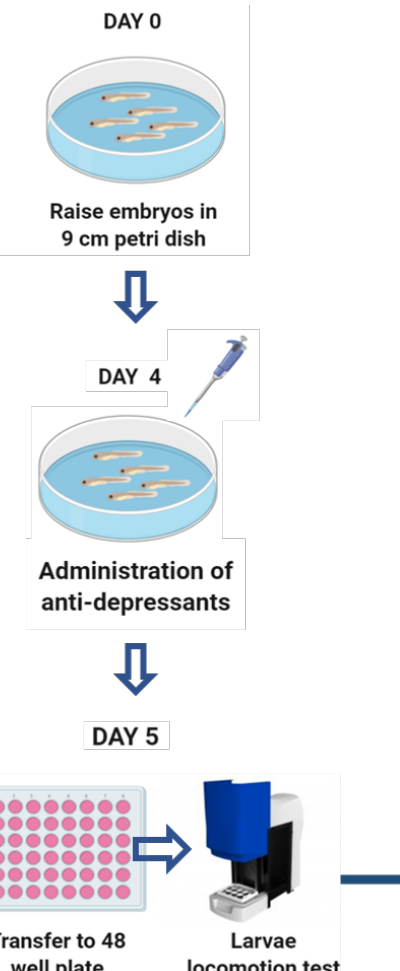
Figure 1. Schematic diagram of the experimental design to evaluate the potential adverse effects of 1 mg/L of 18 different antidepressants in zebrafish larvae. The experimental workflow for antidepressant exposure and locomotor activity measurement for larval zebrafish are illustrated in the upper panel. During locomotion assay, three major endpoints, including total distance traveled, burst count, and rotation count were measured and compared (top-right panel). Finally, two mathematic tools of principal component analysis and hierarchical clustering were used to reduce data complexity and perform similarity grouping (bottom-right panel).